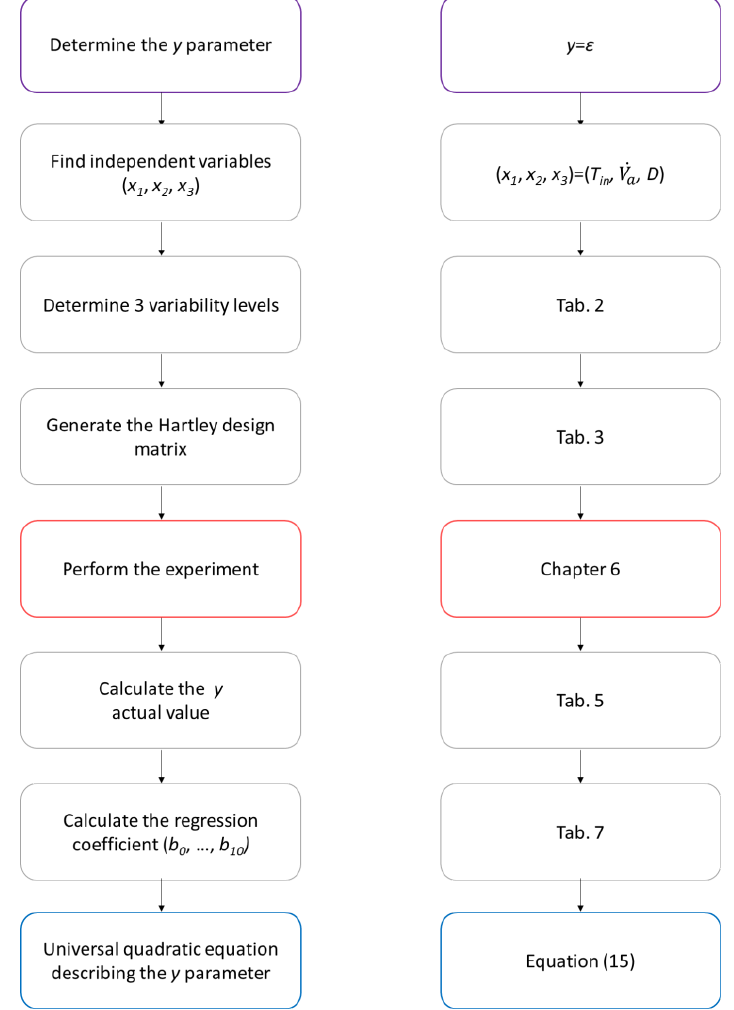
Figure 4. Algorithm of the Hartley design procedure.